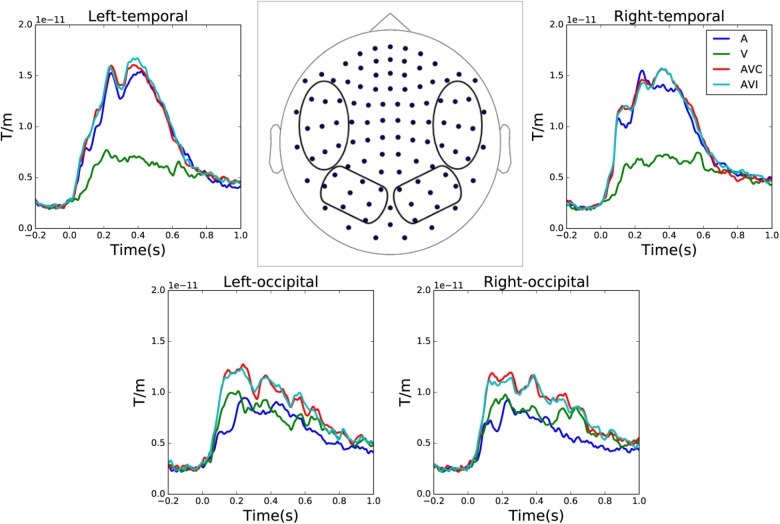
Sensor level grand average of the auditory only, visual only, audiovisual congruent and audiovisual incongruent conditions over left and right temporal and occipital channels. The waveforms are averaged over combined gradiometer channels calculated by vector sum of the two orthogonal gradiometer pairs.